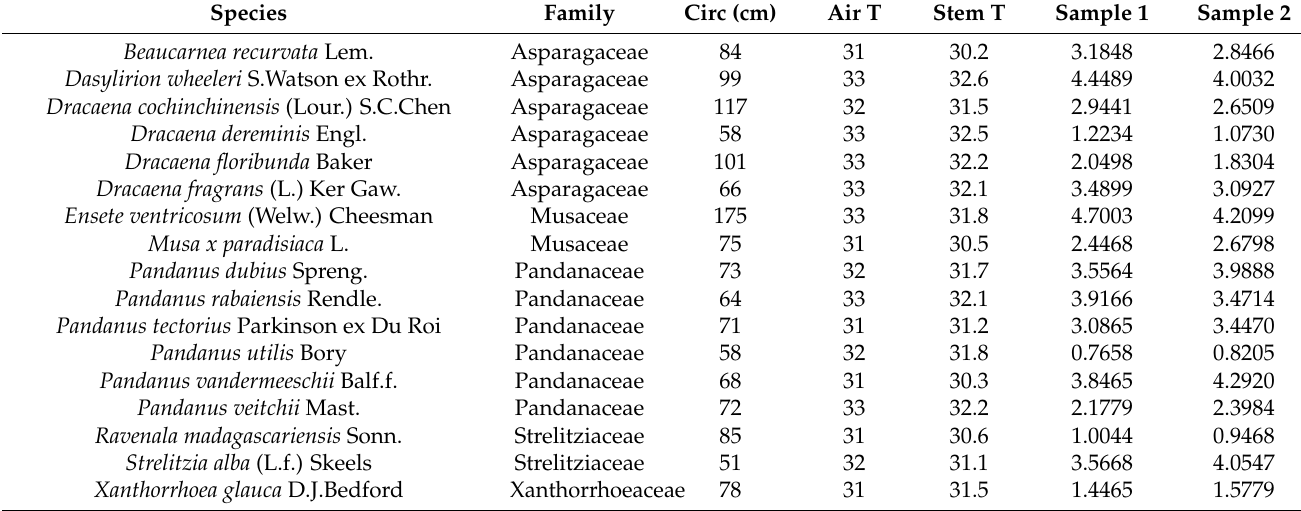
Table A3. List of non-palm arborescent monocot species included the in carbon dioxide efflux study. Circ = circumference, Air T = air temperature, and Stem T = surface temperature of stems.